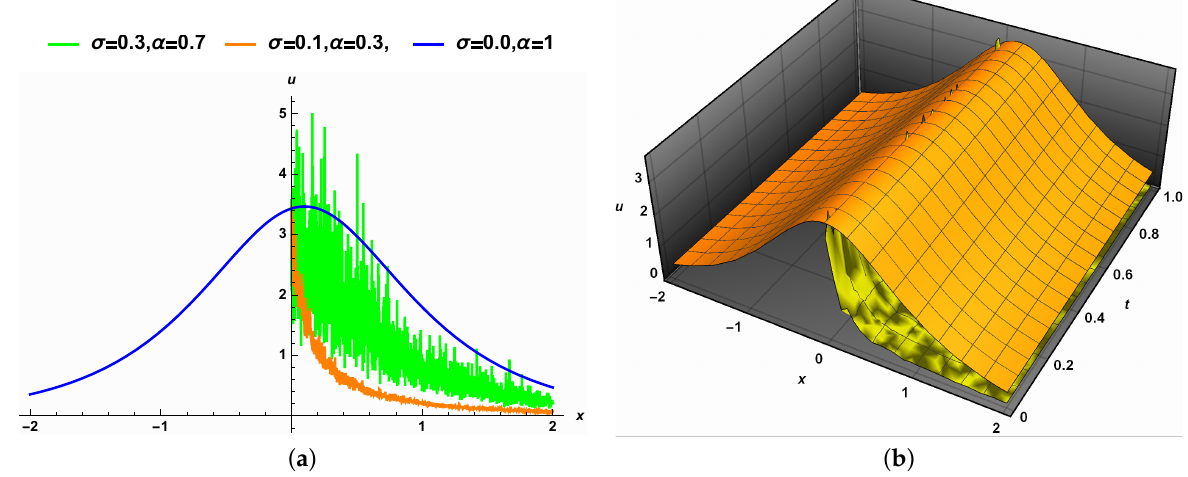
Figure 8. The combined effect of the noise and the fractional order α on the solution